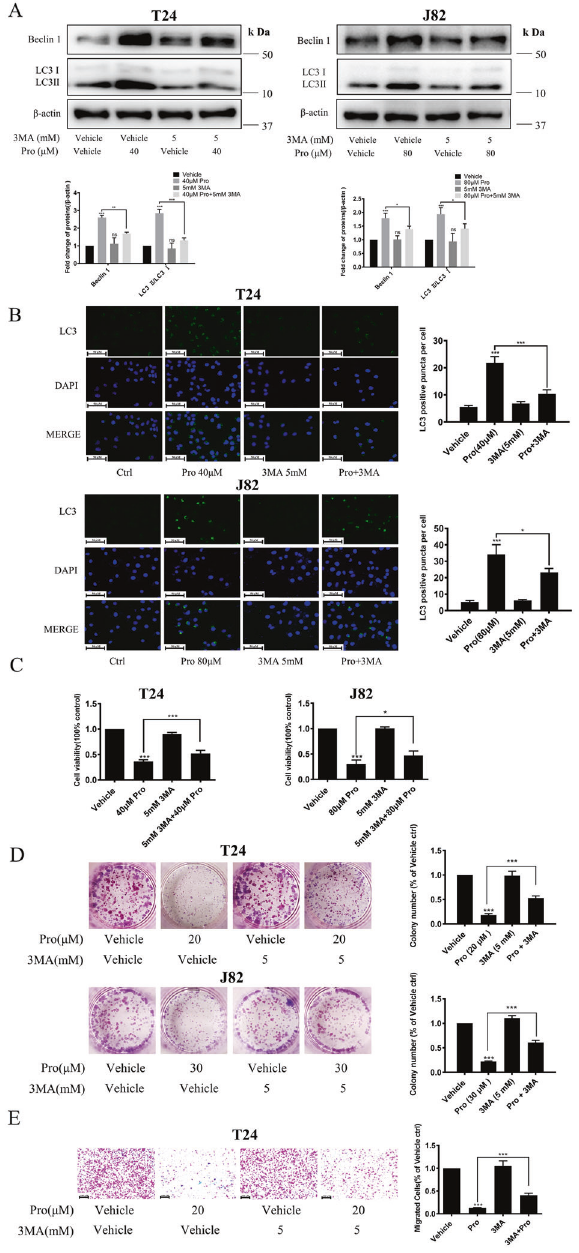
Fig. 7 Inhibition of autophagy by 3-MA reduced the activity of proguanil in BC cells. A T24, J82 were plated in 6-well plates (3.0 × 10 5 /well). When the cell density reaches 70 – 80%, cells were treated with 3-MA (5 mM) and proguanil for 12 h. Western blotting was used to detect the protein expression of LC3 and Beclin-1. B T24, J82 were plated on glass disks in 12-well plates (2.0 × 10 4 /well), After 24 h, cells were treated with 3-MA (5 mM) and proguanil, immuno fl uor- escence was used to detect the protein expression of LC3. C Cells were plated in 96-well plates (6.0 × 10 3 /well), After 12 h, cells were treated with 3-MA (5 mM) and proguanil, the inhibitory effects of proguanil and 3-MA on proliferation were detected by MTT. D Cells were plated in 24-well plates (2.0 × 10 3 /well), After 12 h, cells were treated with 3-MA (5 mM) and proguanil, the he inhibitory effects of proguanil and 3-MA on proliferation were detected by colony formation assay. E The inhibitory effects of proguanil and 3-MA on migration were detected by transwell as described in “ Materials and methods ” . Data are representative of three independent experi- ments. Error bars represent means ± SD from triplicate experiments. Vehicle control means the concentration of DMSO lower than 0.3% (* P < 0.05, ** P < 0.01, *** P < 0.001, ns not signi fi